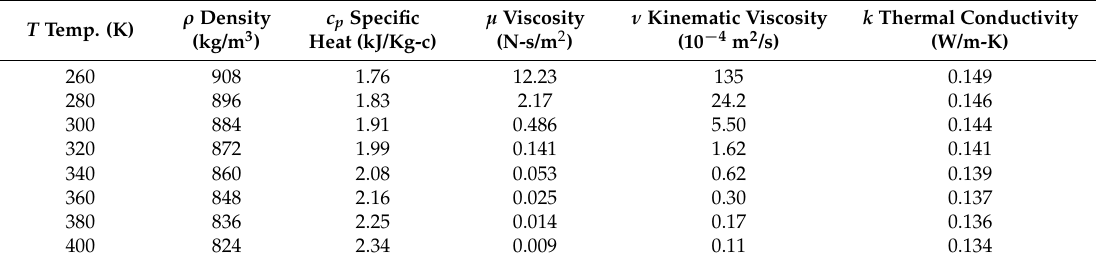
Table 2. Thermo-physical properties of the SAE 10W-30 synthetic blend engine oil. T Temp.